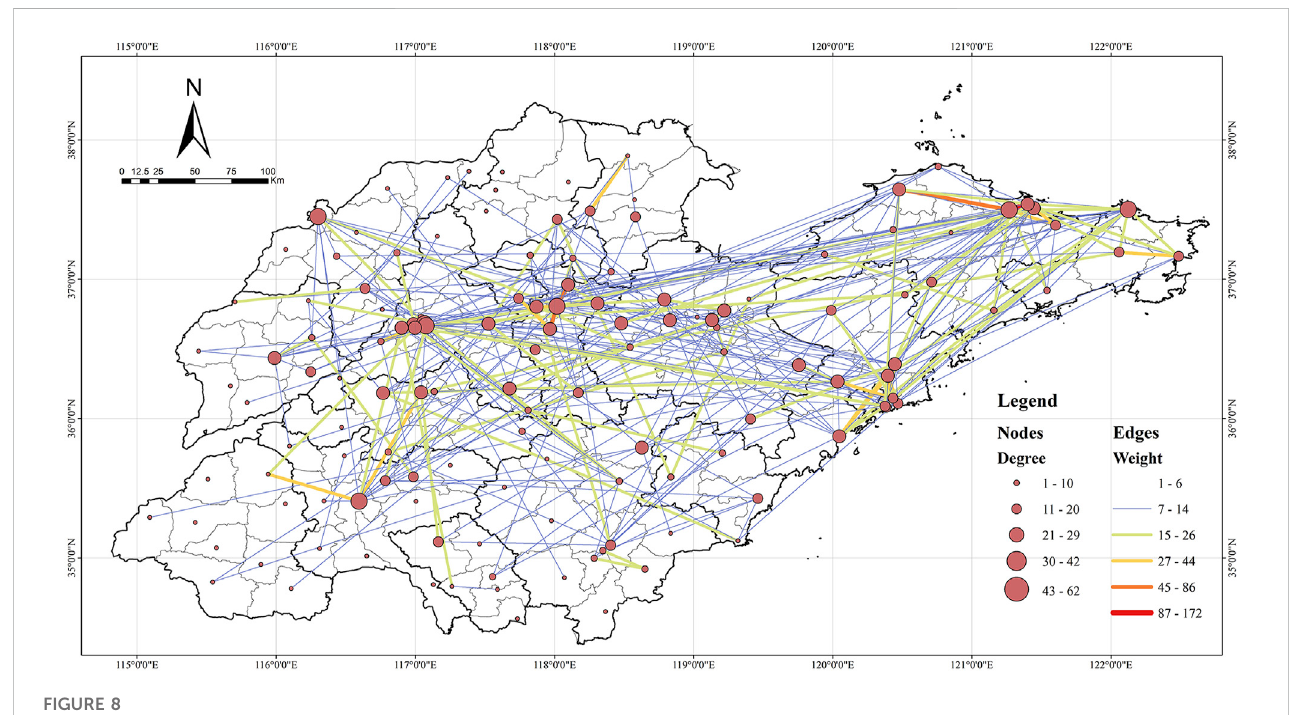
FIGURE 8 Spatial Pattern of City Supply Networks in